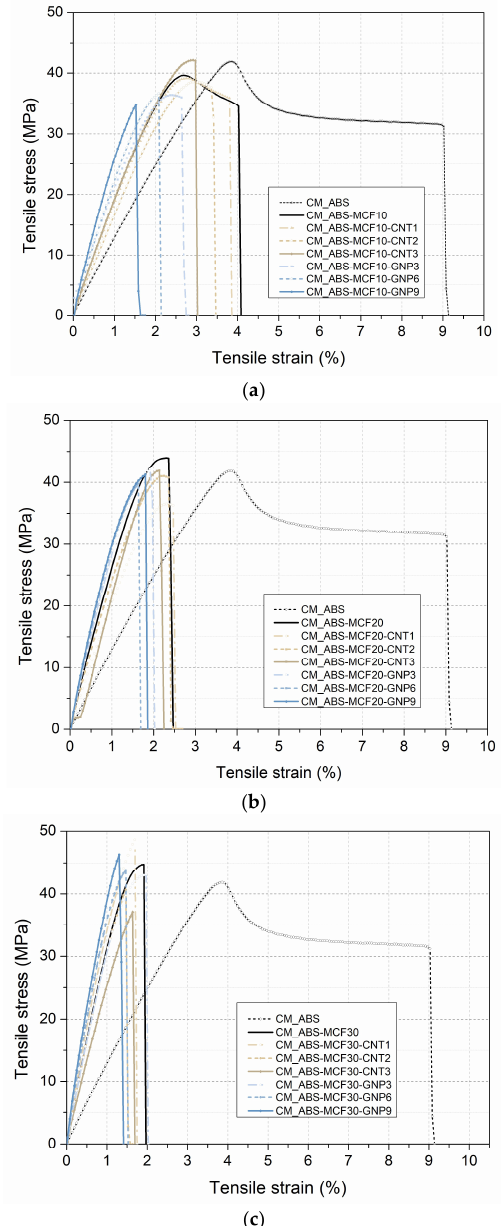
Figure 5. Representative stress–strain curves of multiscale composite CM samples as a function of ( a ) 10 wt.% MCF and different CNT and GNP contents; ( b ) 20 wt.% MCF and different CNT and GNP contents; and ( c ) 30 wt.% MCF and different CNT and GNP contents.